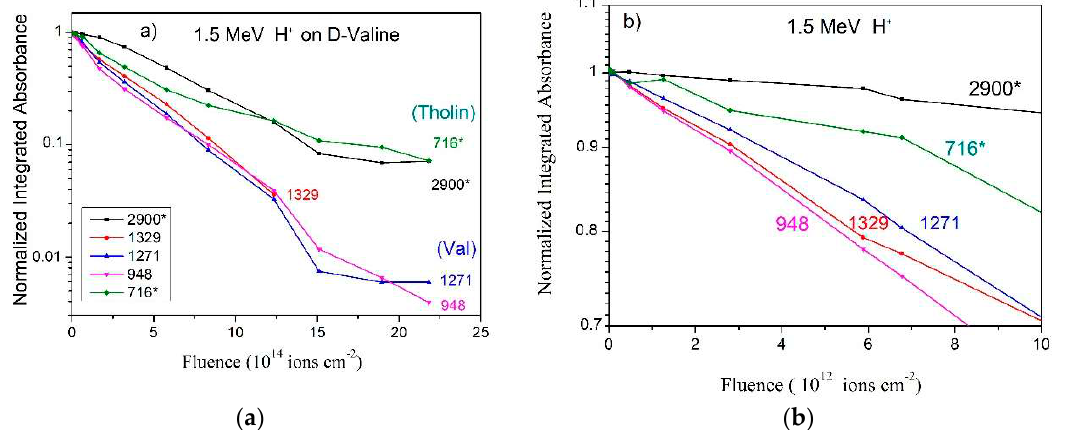
Figure 3. Dependence on fluence of the integrated absorbance for several bands observed in the H + beam irradiation:( a ) up to the fluence 25 × 10 14 ions cm -2 ; ( b ) up to the fluence 1 × 10 13 ions cm -2 . Data